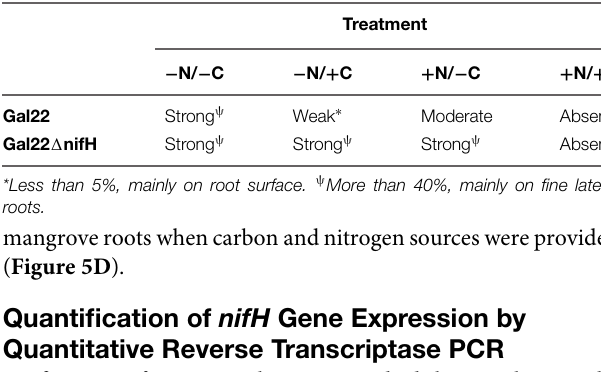
colonization. (C) Colonization within young-fine lateral roots. (D–F) Root recovered after the treatment + N/ + C. No bacterial colonization was observed in treatments were carbon and nitrogen were supplemented in the media.